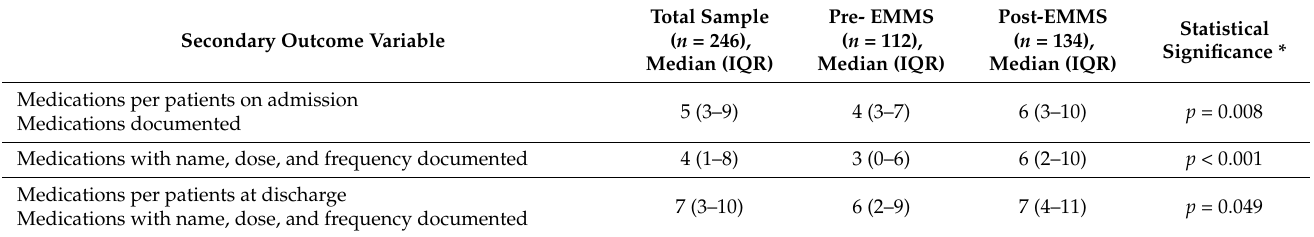
Table 3. Analysis of medications with complete information before and after the implementation